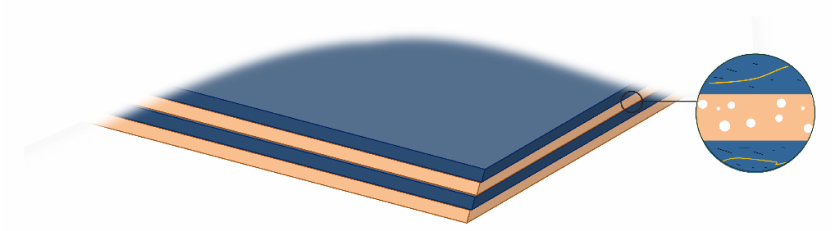
Figure 1. Schematic illustration of layer multiplying co-extrusion.